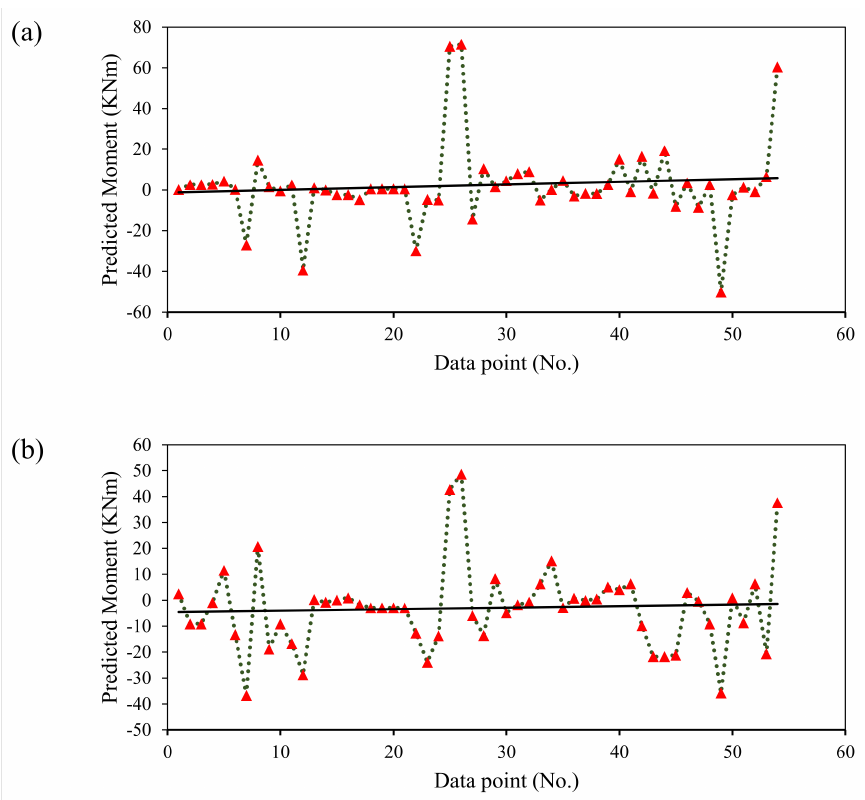
Figure 6. Error Analysis of the proposed models in the validation phase: ( a ) DT, and ( b ) GBT.